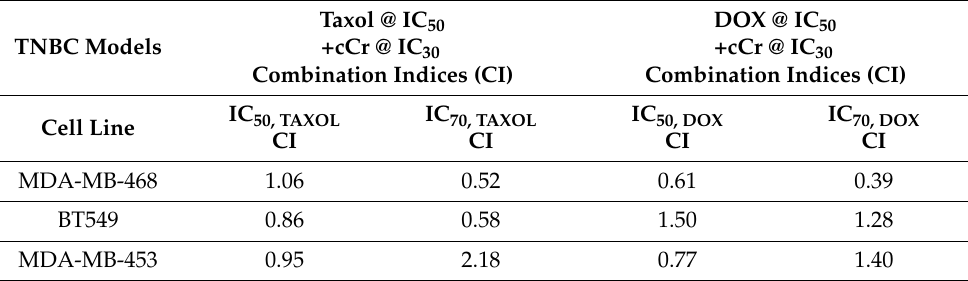
Table 3. Combination indices calculated for human TNBC cell lines pairing cCr with either Taxol or DOX. Isobole studies were performed, and data representative of 2 independent isobole assays are